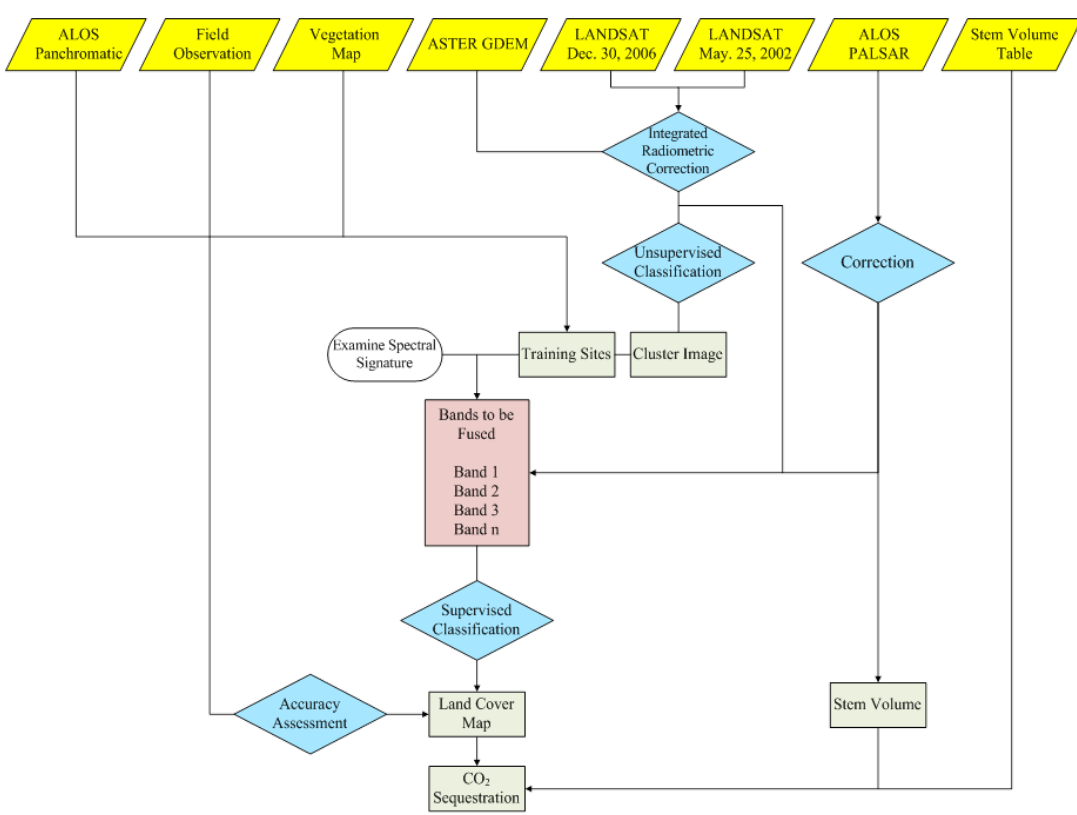
Figure 3. The analysis